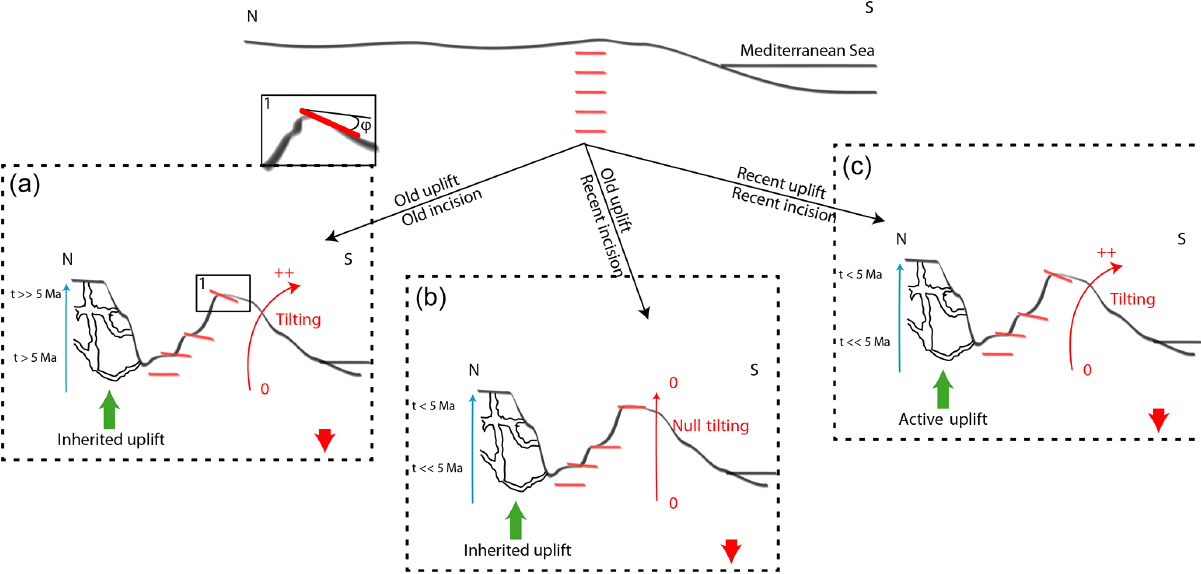
Figure 2. Conceptual models for landscape evolution. Top panel is the initial stage (prior to uplift). Each panel represents a possible scenario explaining current morphology: (a) old uplift and old incision, (b) old uplift and recent incision, and (c) both recent uplift and incision. Blue arrows and associated ages show expected result (or absence of) for burial dating. Red level represents morphological markers that are fossilized when reaching the surface, accumulating afterward (or not) the differential uplift by finite tilting.